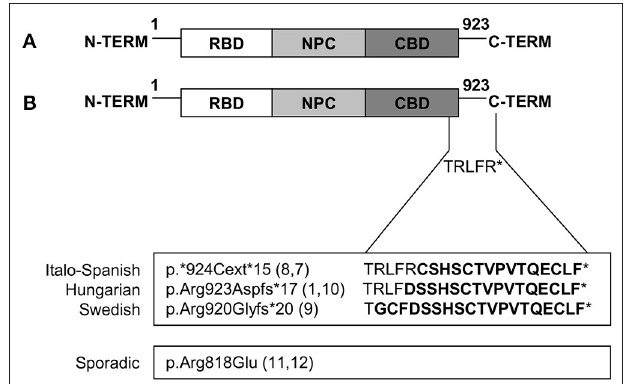
FIGURE 4 | Mutations in TNPO3 that cause LGMD D2 TNPO3-related. (A) Graphic representation of wild-type TNPO3 showing the N-terminal RanGTP-binding domain (RBD), nuclear pore complex (NPC)-binding domain, and a C-terminal cargo-binding domain (CBD). (B) Graphic representation of all the described mutations (familial and sporadic